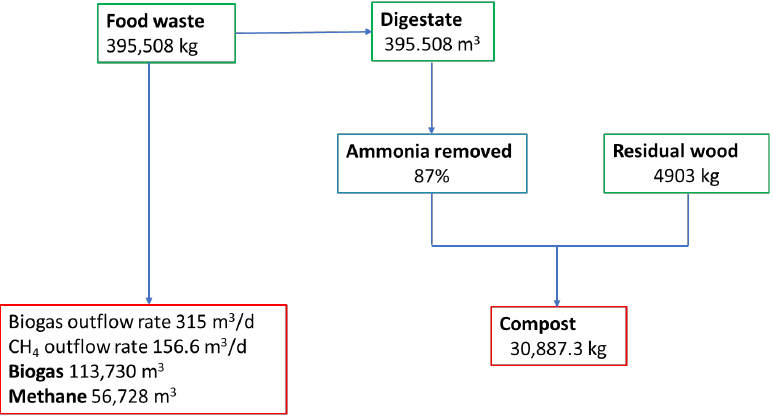
Figure 13. Products and their amounts obtained on the second branch of the